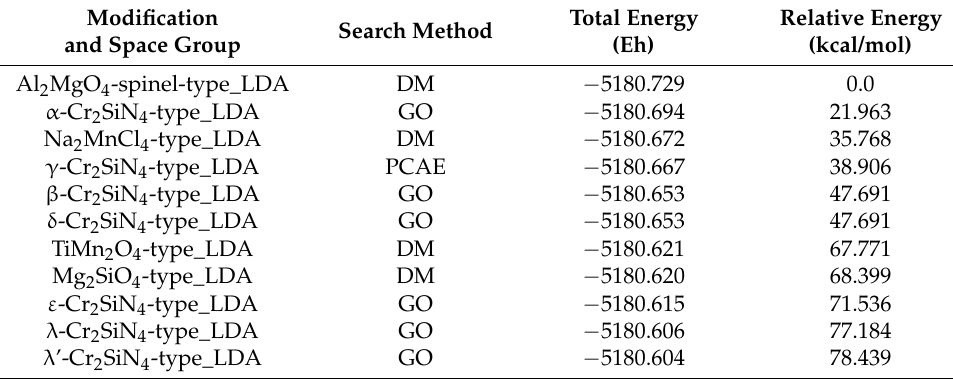
Table A2. The total energy and relative energy values compared to the global minimum (spinel structure taken as the zero of energy) of the energetically most favorable Cr 2 SiN 4 modifications found using various search methods and later locally optimized on the ab initio level using the LDA-PZ functional. DM stands for data mining, GO stands for global optimization, and PCAE stands for primitive cell approach for atom exchange